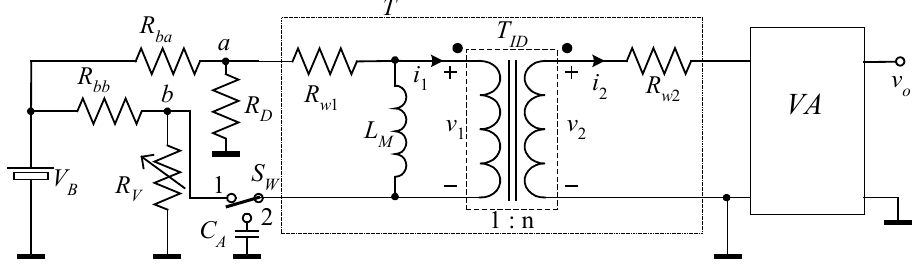
Figure 2. Simplified schematic of a transformer-coupled amplifier. VA is a FET input operational amplifier with a constant gain A V and very large input impedance.